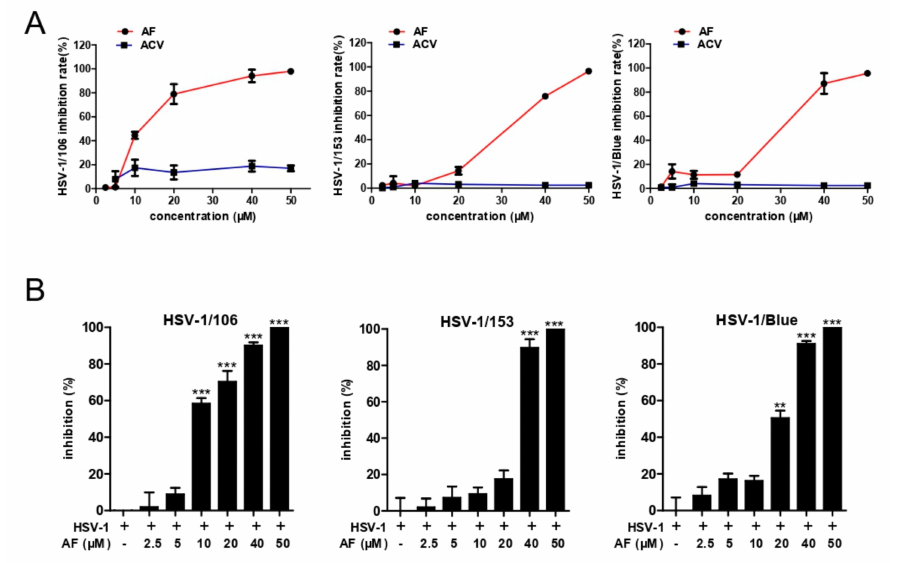
Figure 3. Amentoflavone inhibits infection by ACV-resistant HSV-1 strains. ( A ) Vero cells were infected with HSV-1 / 106, HSV-1 / 153, and HSV-1 / Blue (MOI = 0.1) in the presence of amentoflavone or ACV for 72 h. The antiviral e ff ect was assessed by CCK8 assay. ( B ) Vero cells were infected with HSV-1 / 106, HSV-1 / 153, and HSV-1 / Blue (MOI = 0.1) for 2 h. The viruses were then removed and cover fluid with amentoflavone was added. After 72 h, the cells were fixed and strained with crystal violet dye. The plaque numbers were counted to calculated the inhibitory e ff ect. Data are mean ± SD ( n = 3). ** p < 0.01, *** p < 0.001 versus HSV-1-treated